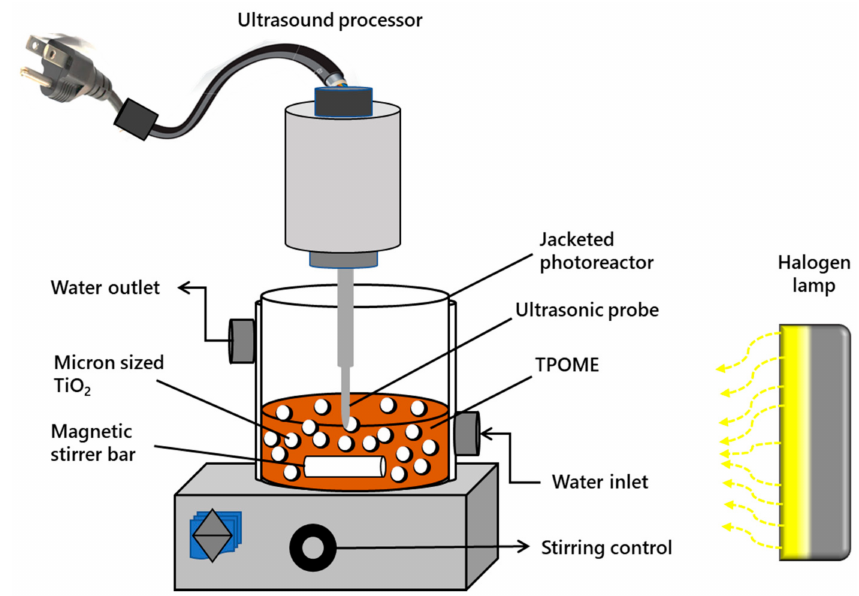
Figure 2. Experimental setup for carrying out TPOME remediation